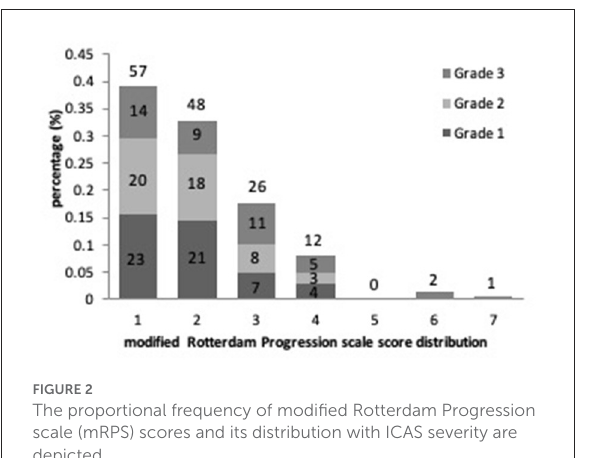
FIGURE3 Several cases with different WMHs and ICAS. (A) mild PVWMHs; (B) moderate PVWMHs; (C) severe PVWMHs; (D) mild SCWMHs;